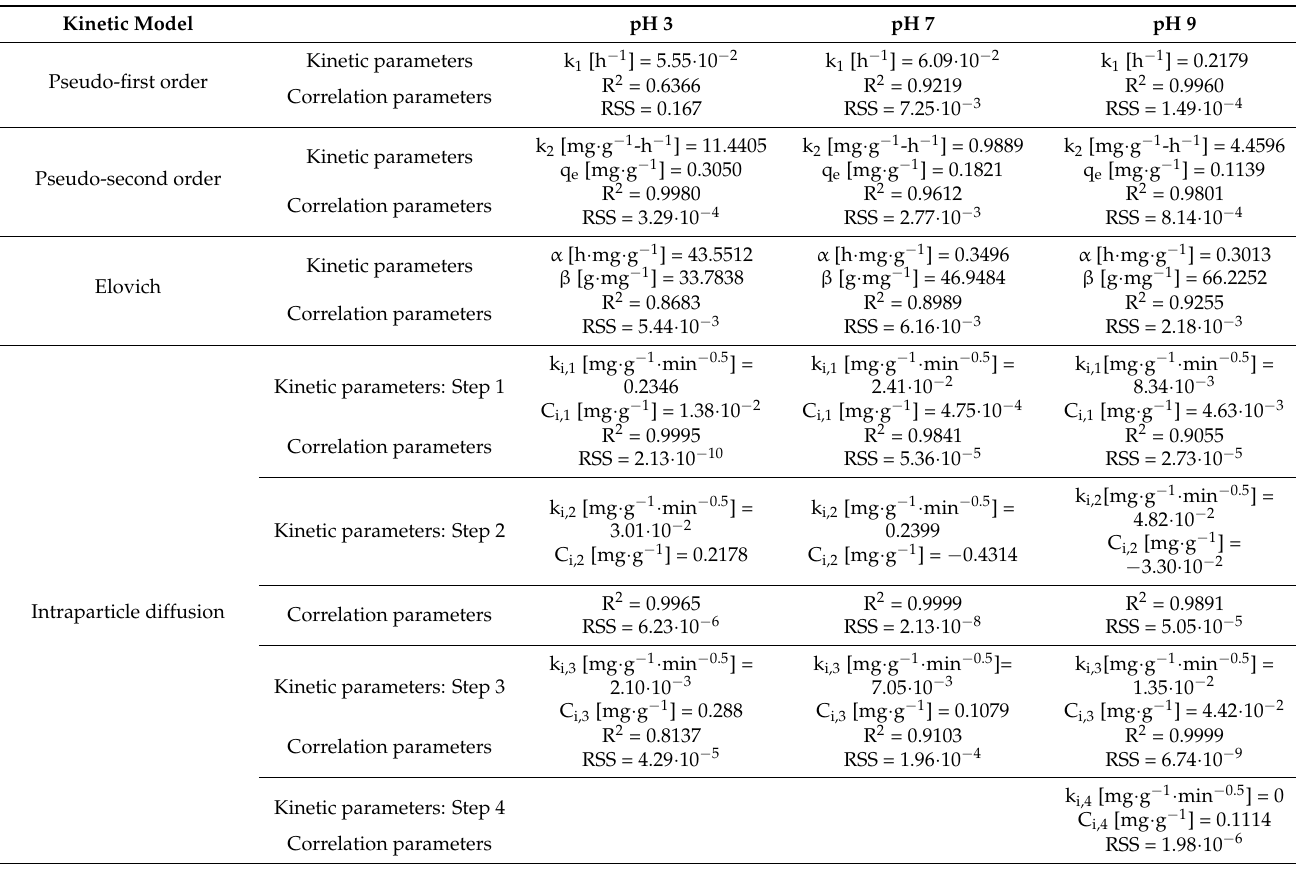
Table A2. The results of the kinetic equation adjustment to the adsorption experimental data of